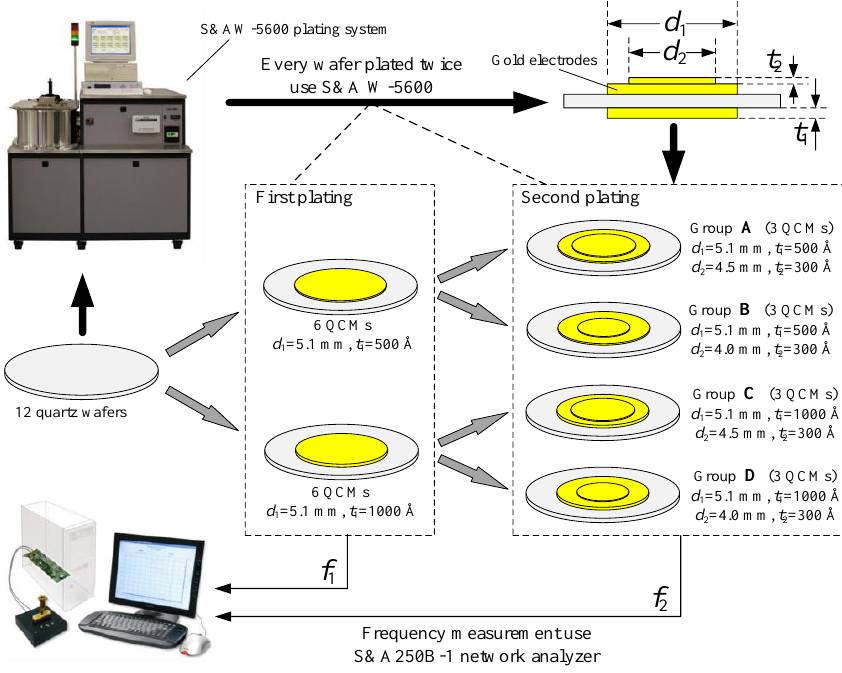
Figure 5. Schematic diagram of the experimental set-up.